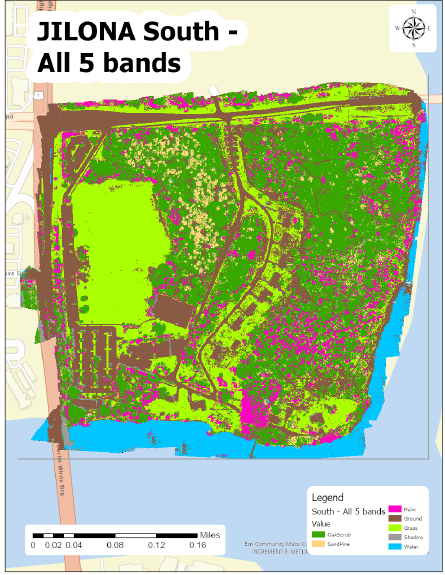
Figure 11: JILONA south classification using all 5 bands